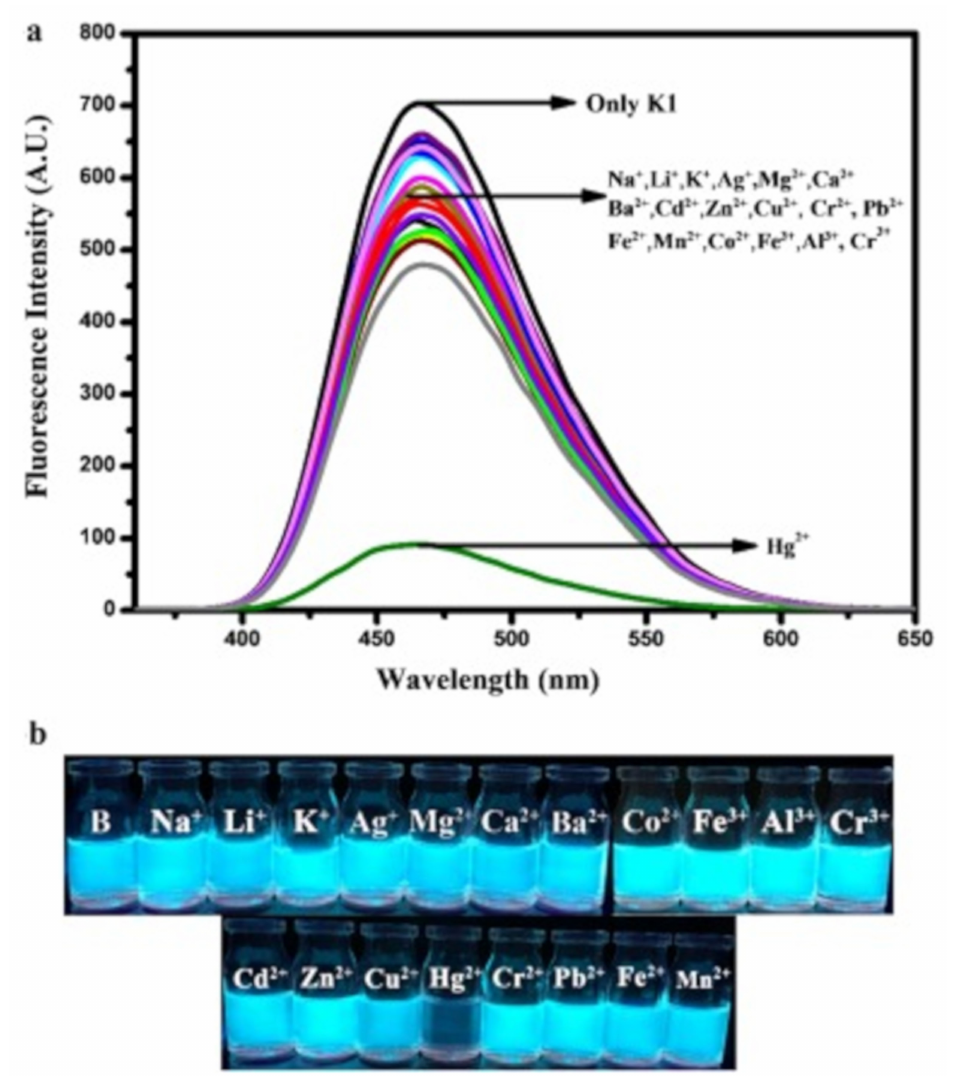
Figure 4. ( a ) Fluorescence spectra of 1 (K 1 = 1) and ( b ) photographs of 1 (B = 1) under UV in the absence and presence of 20 µ M metal ions in water. Reproduced with permission from [32]. Copyright 2020